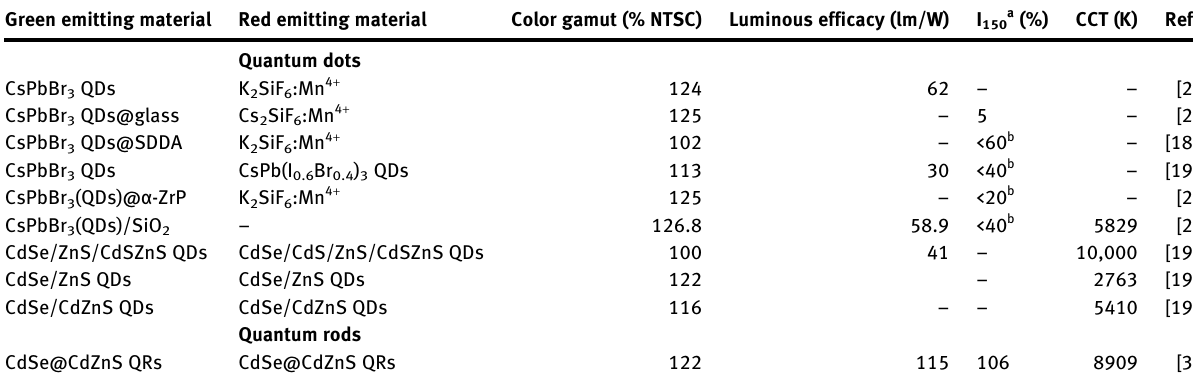
Table  : Comparison of performance for the reported wide color gamut white LEDs for display applications [  ]. Green emitting material